Question: In a single sentence, describe what this figure presents.
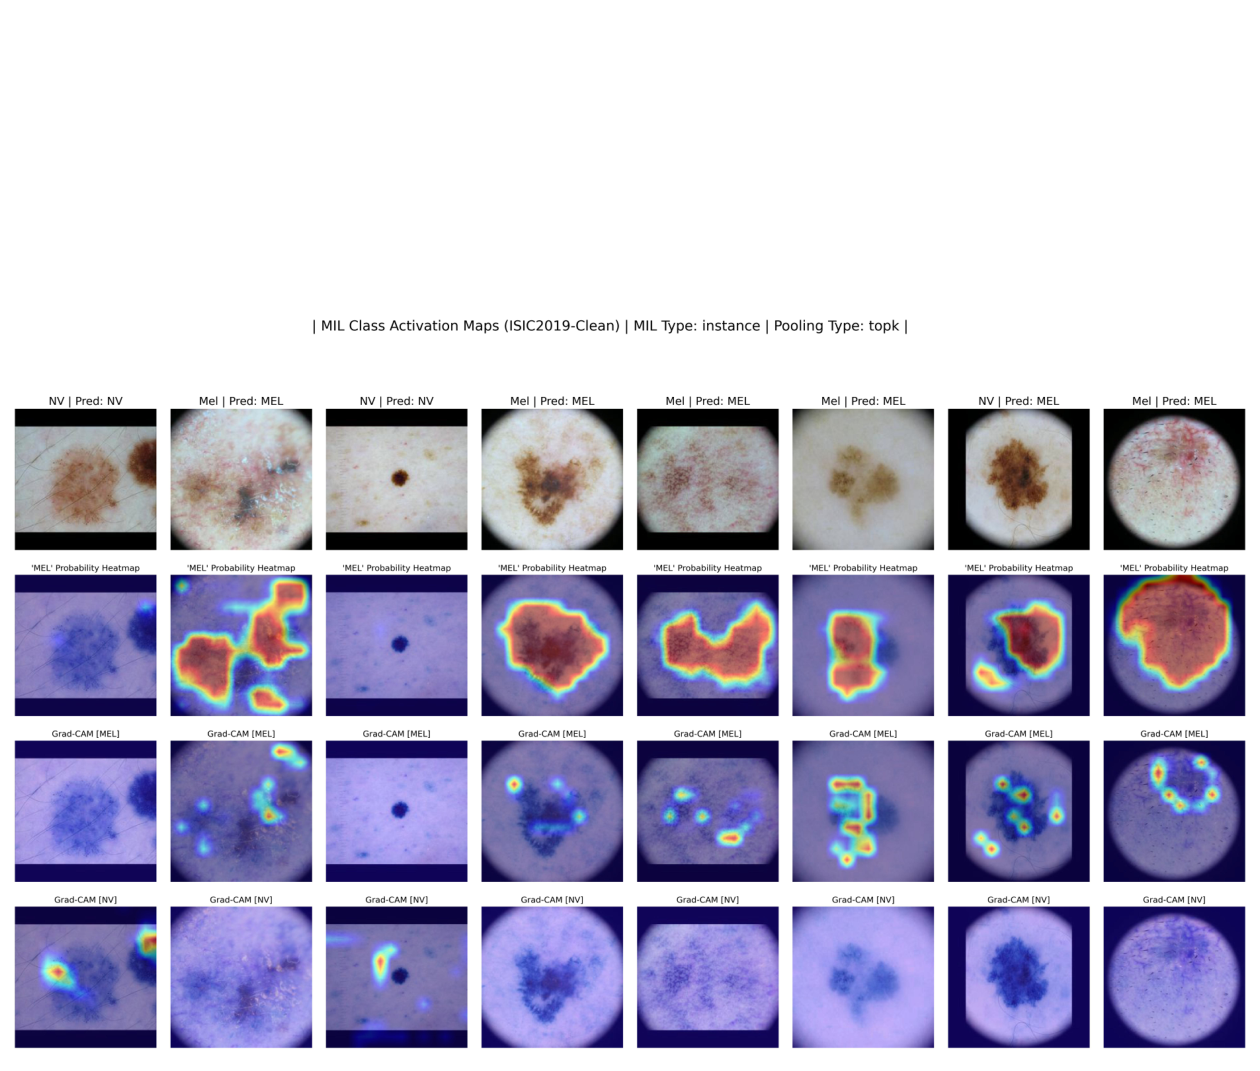
Answer: Visualization of the heatmaps generated by the MIL classifier, specifically the instance-level MIL model using the top-k average pooling operator. The backbone used for the MIL model is the RN-18. The images are taken from the validation set of the ISIC 2019 dataset, and belong to the binary problem of melanoma vs. nevus. The Figure shows the input images in the first row, followed by the patch probability heatmap for the melanoma class in the second row. The third row shows the gradient heatmap for each patch. In this case, the last row shows the gradients with respect to the patches that the model predicted to be nevus.